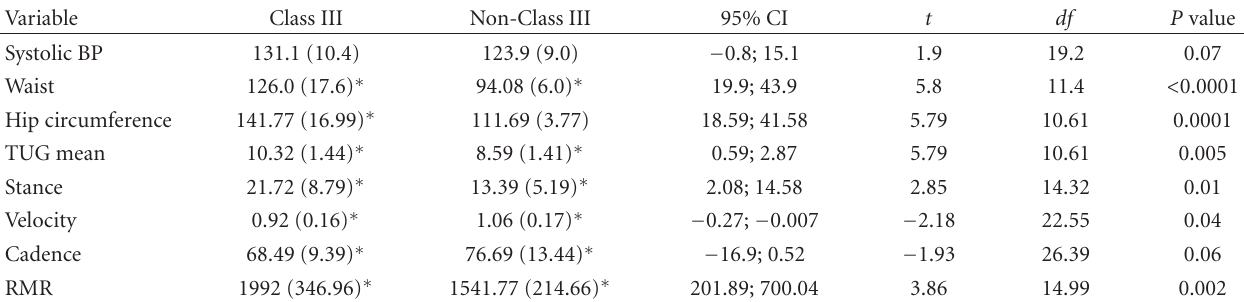
Table 4: Mean ∗ BP, anthropometric, and gait measures by BMI group.